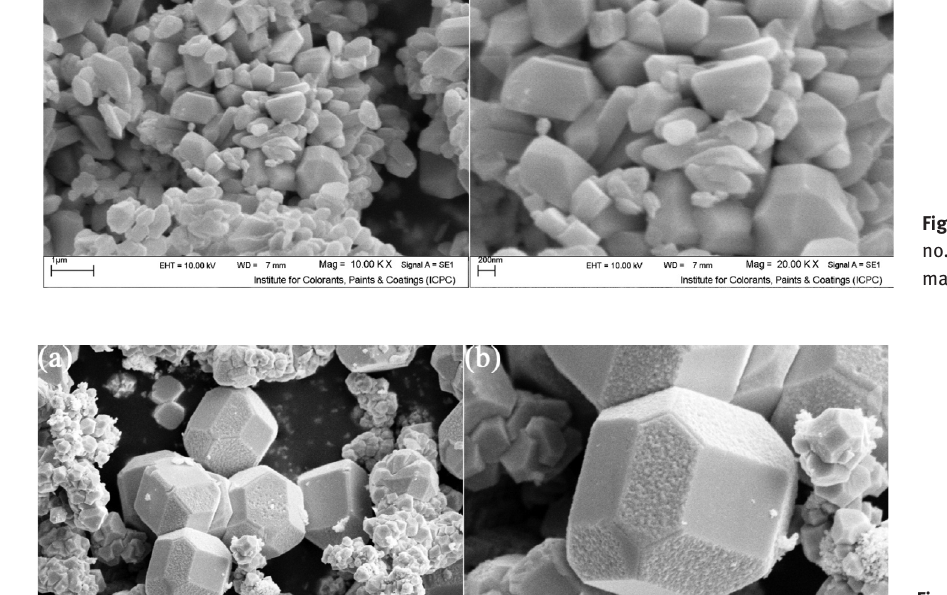
Figure 13 (a, b): SEM image of sample no. 5 with 3 KX and 8 KX magnification, respectively.